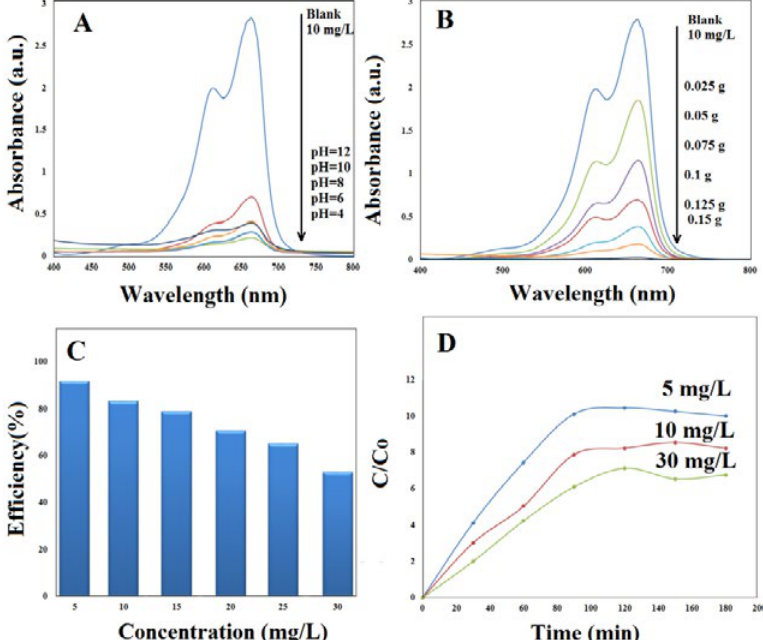
Fig. 8. (A) Study of MB adsorption onto Fe weight of adsorbent, (C) removal efficiency of MB onto Fe